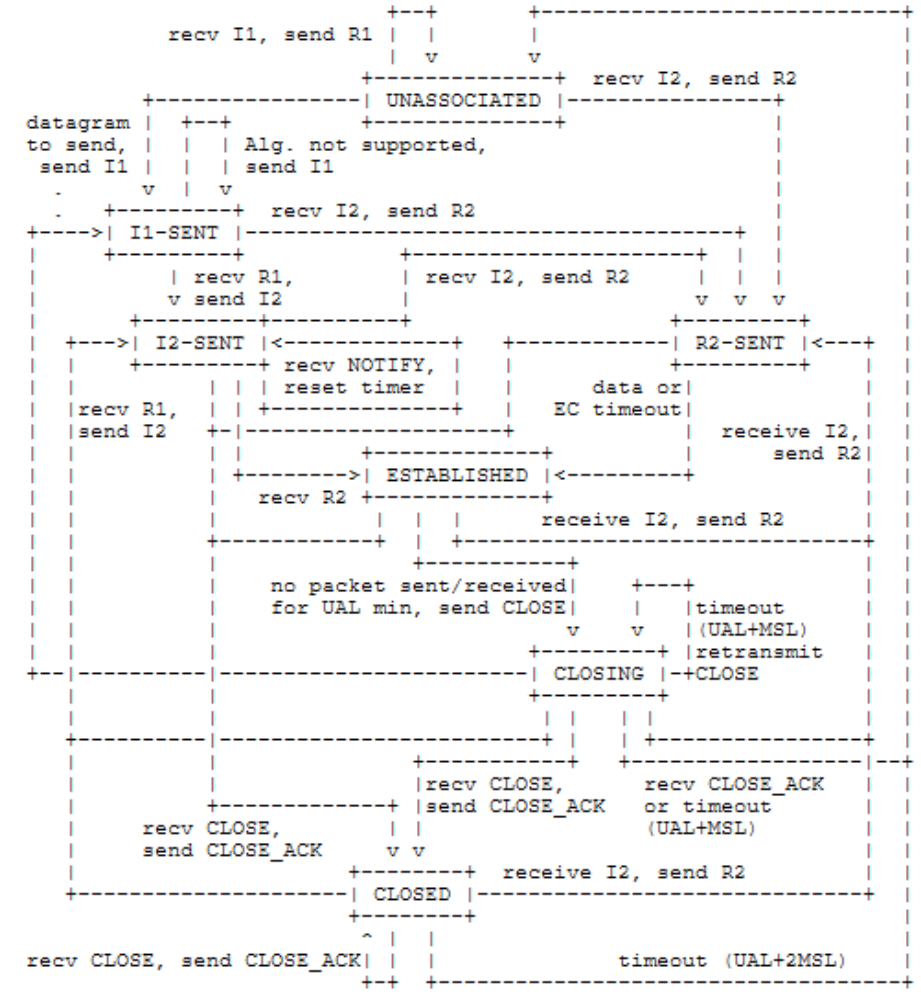
Figure 5. HIP state machine diagram